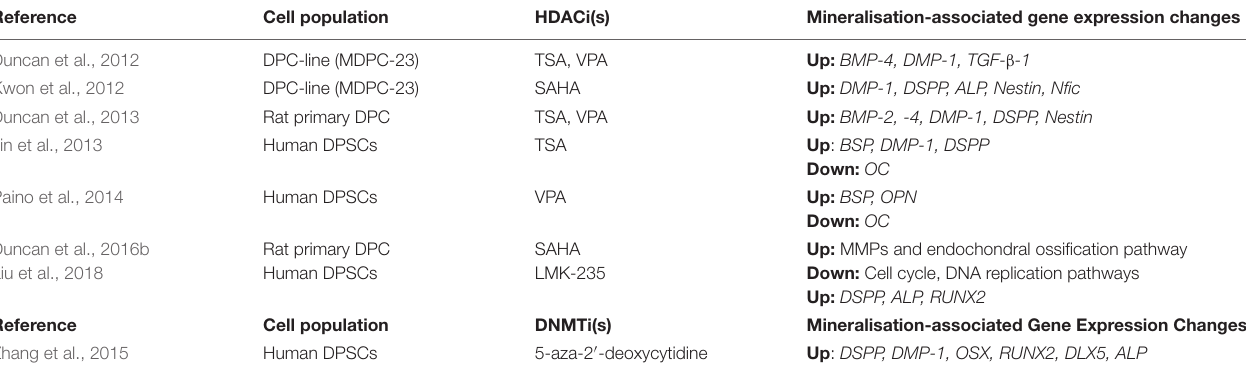
TABLE 1 | Table presenting various studies which have investigated the effects of histone deacetylase inhibitors (HDACis) and DNA methyltransferase inhibitors (DNMTis) on mineralisation and differentiation in dental pulp cell populations.